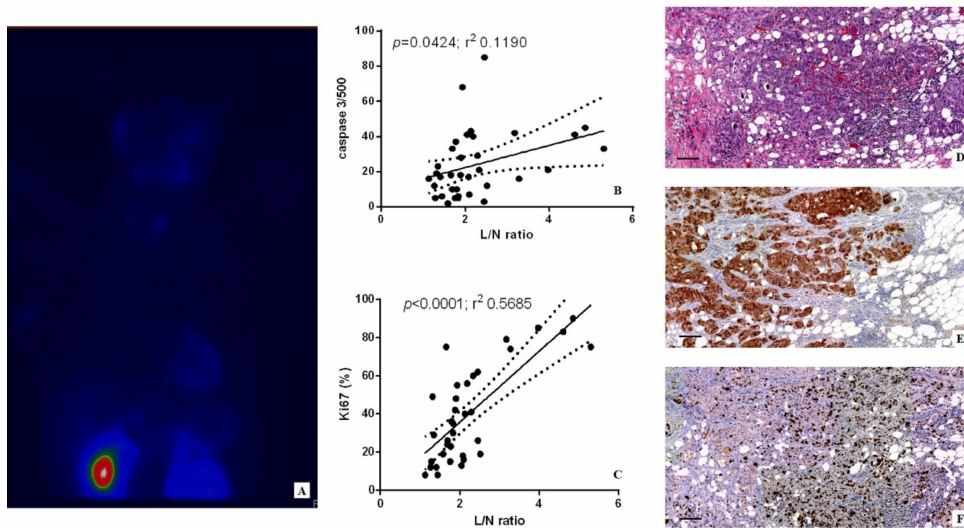
Figure 1. Breast-specific γ imaging with [99mTc]Tc-Sestamibi and both caspase-3 and Ki67 expression. ( A ) Maximum-intensity projection of breast-specific γ imaging with [99mTc]Tc-Sestamibi in a 69- year-old breast cancer patient. ( B ) The graph shows the positive and significant association between the number of caspase-3-positive breast cancer cells and the sestamibi uptake (L/M ratio). ( C ) The graph displays significant association between the number of Ki67-positive breast cancer cells and the sestamibi uptake (L/M ratio). ( D ) T hematoxylin and eosin section shows G3 infiltrating breast carcinomas (scale bar represents 50 µ m). ( E ) The image displays numerous caspase-3-positive breast cancer cells (scale bar represents 50 µ m). ( F ) High percentage of Ki67-positive breast cancer cells (scale bar represents 50 µ